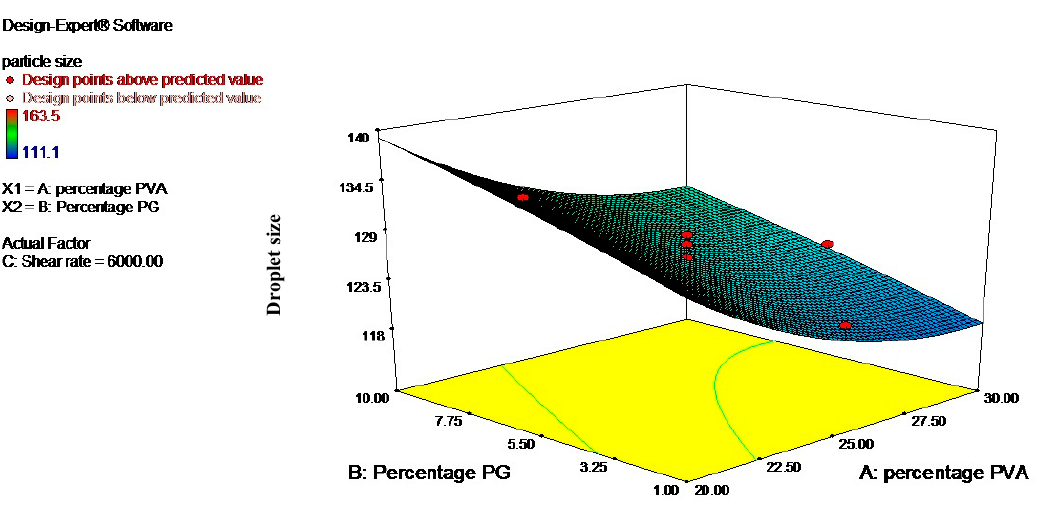
Figure 1. Three-dimensional surface graphs showing the effect of percentage PVA and percentage PG on droplet size; shear rate was kept constant.